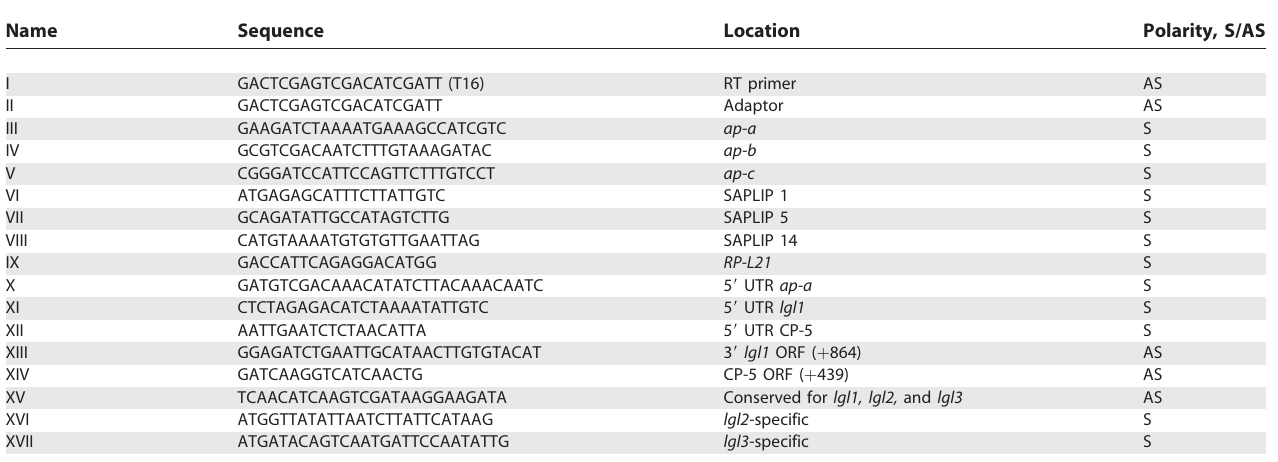
Table 1. Primers Used for